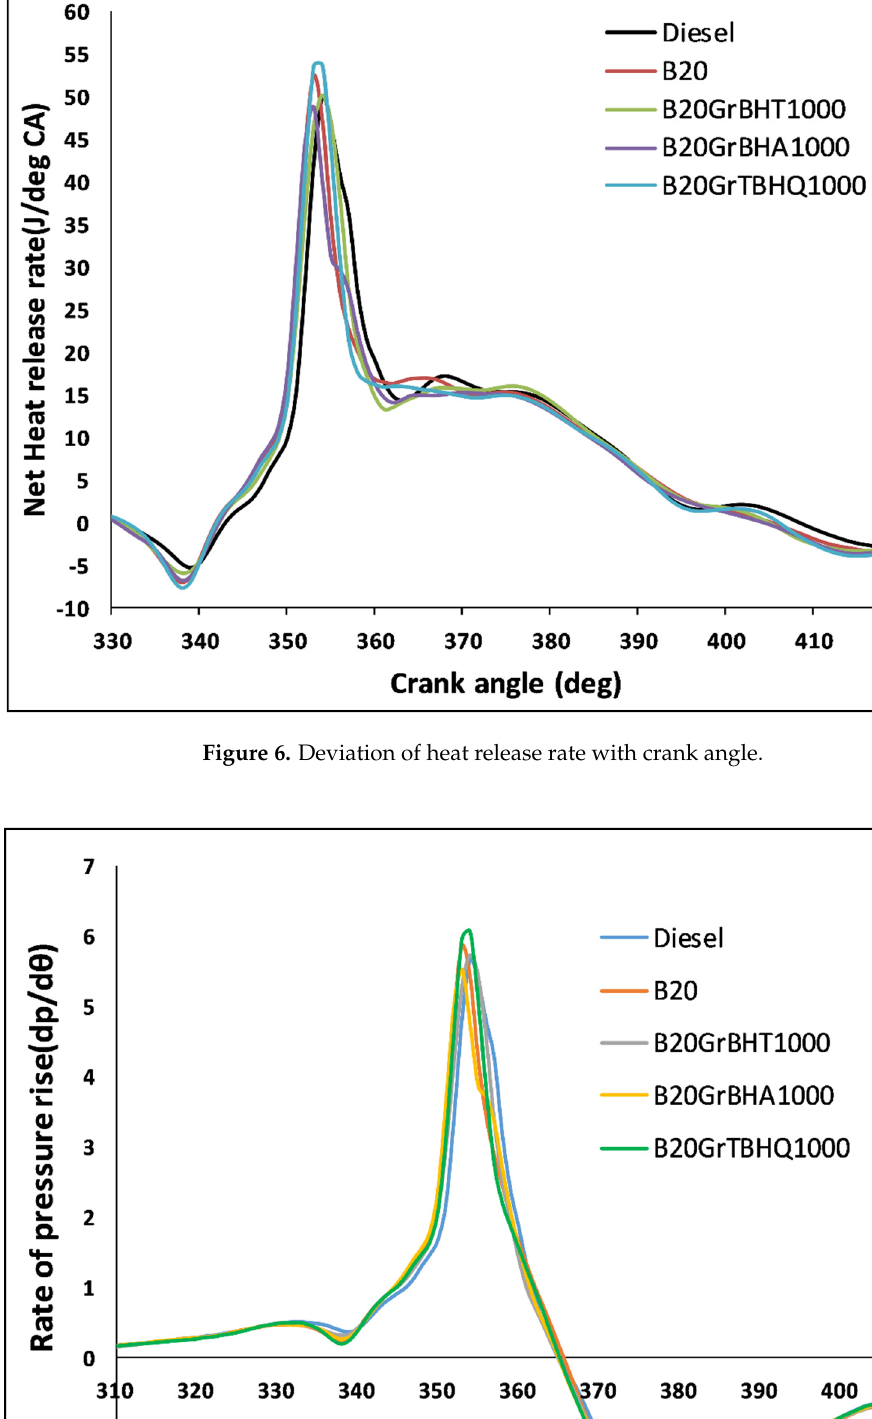
Figure 8. Deviation of pressure rise rate with loading. 5.7. CO Emission Figure 9 shows deviation of carbon monoxide emission with loading for diesel, B20 and graphene plus antioxidant added fuel samples. Carbon monoxide emission increases with an increase in loading. The foremost cause for the same was that the fuel becomes